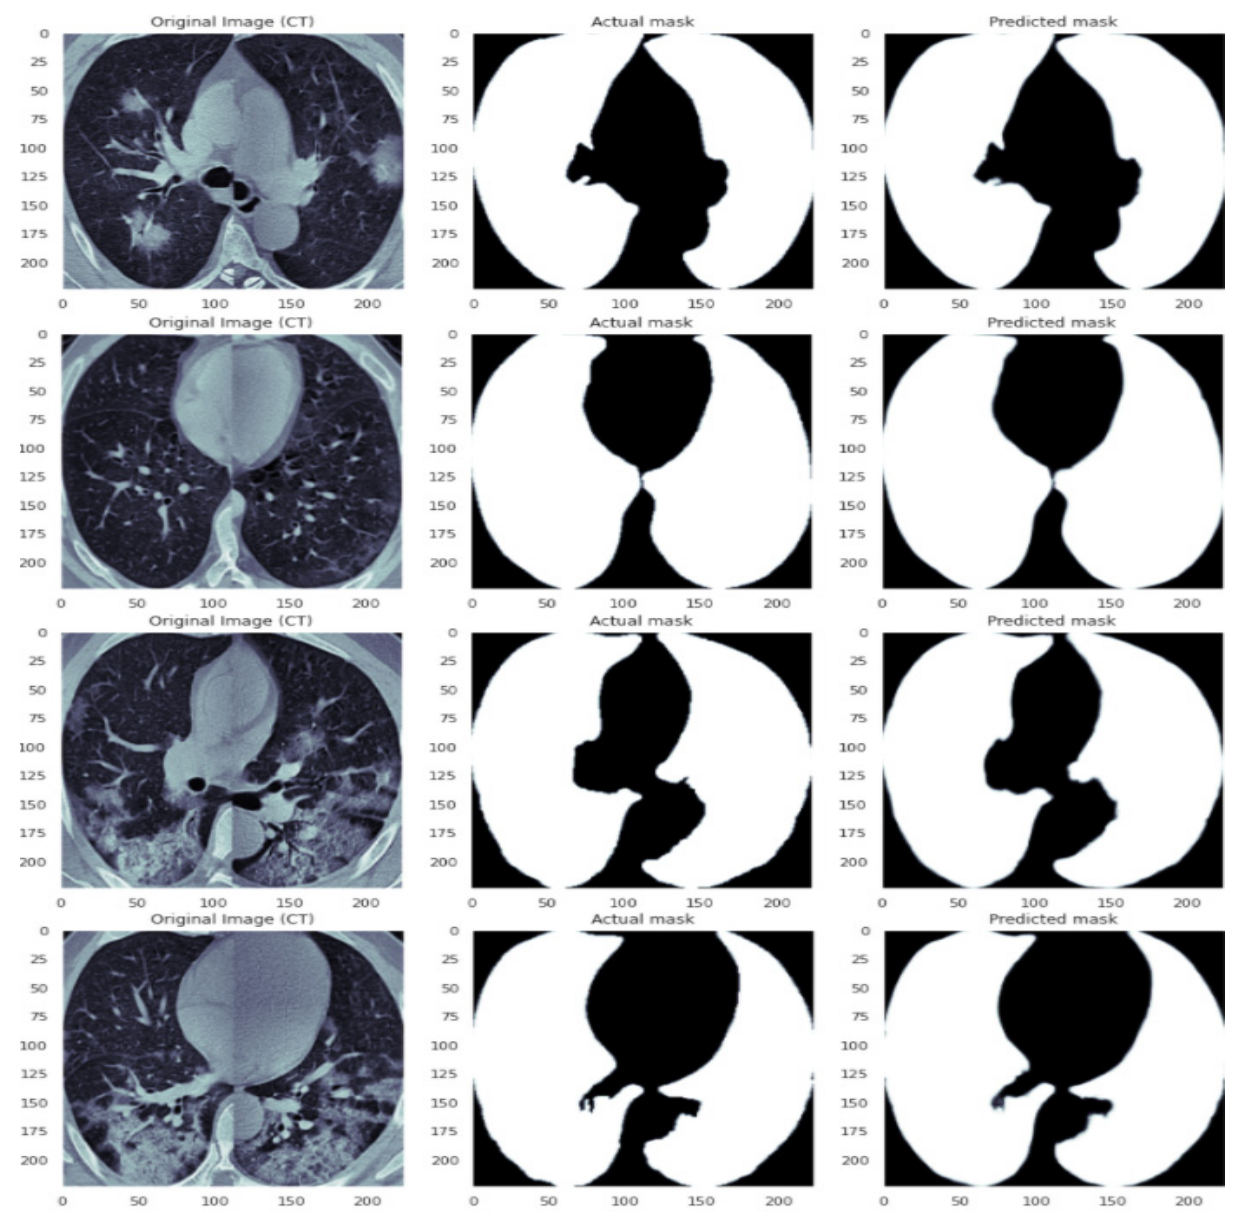
Figure 13. Visual qualitative comparison of the lungs segmentation results between the ground truth and our proposed model on four slices from different CT scans. First column: original CT scan. Second column: ground truth. Third column: predicted lung masks.